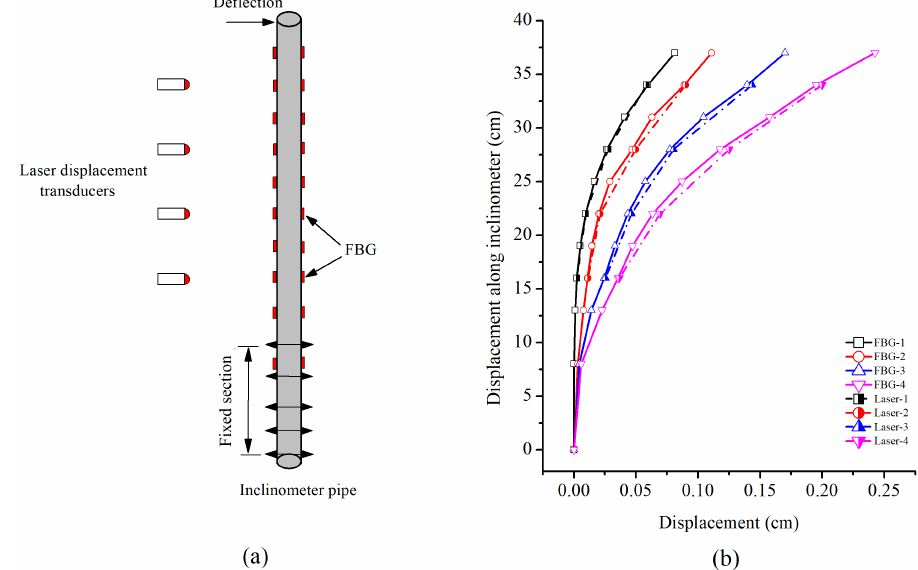
Figure 6. Calibration of the inclinometer pipe ( a ) Simple diagram of the calibration test ( b ) Comparison of the displacement obtained by the FBG-based inclinometer and laser displacement transducers.